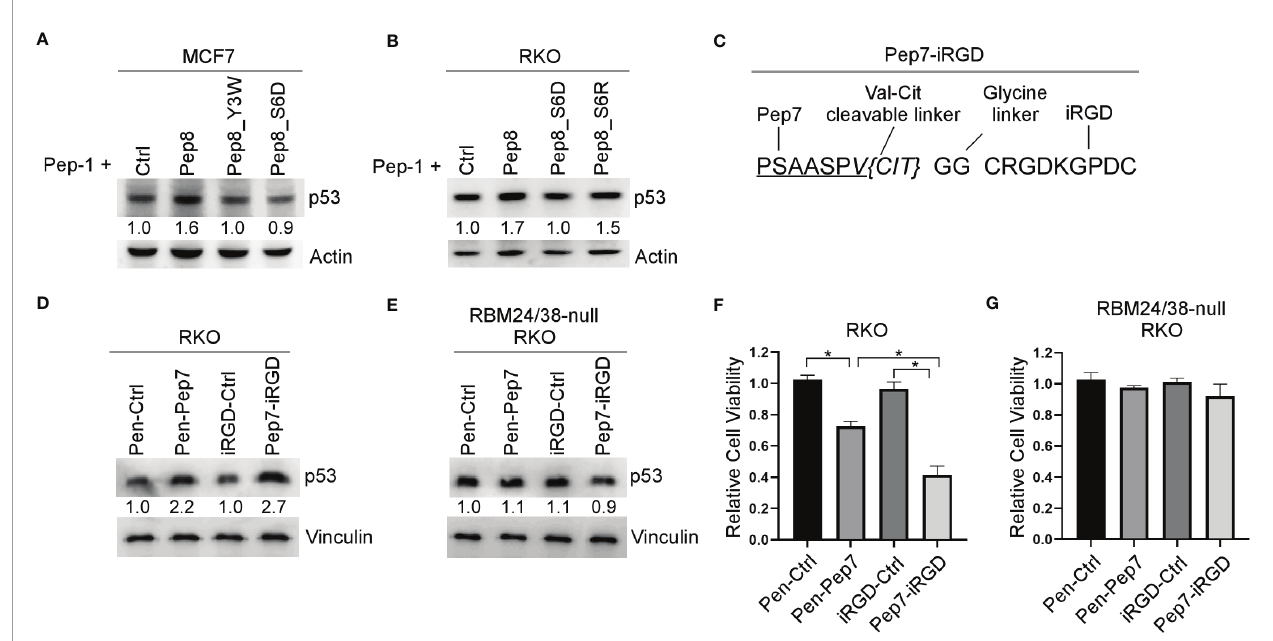
FIGURE 4 | iRGD is the optimal CPP for intracellular delivery of Pep7. (A, B) The levels of p53 and actin proteins were measured in MCF7 (A) or RKO (B) cells treated with Pep-1 delivered peptides (375 nM) for 18 hrs. (C) Peptide sequence for iRGD-conjugated Pep7. (D, E) The levels of p53 and vinculin were measured in wild-type (D) and RBM24/RBM38 double knockout (E) RKO cells treated with Penetratin or iRGD delivered peptides (20 µM) for 18 hrs. (F, G) Relative cell viability was measured in wild-type (F) and RBM24/RBM38 double knockout (G) RKO 2-D cell cultures treated with indicated peptides for 24 hrs. Values represent the mean ± SEM of three independent experiments (*, P <